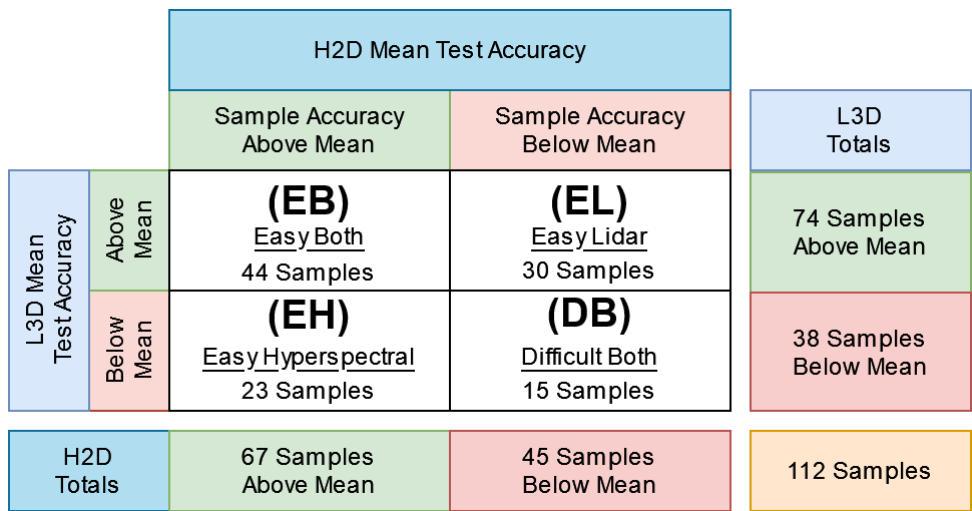
Figure 11. Categorization matrix for test samples. The mean test set accuracy for the H2D and L3D models are calculated. Each test sample is then categorized into one of four types based on the pixel accuracy achieved by both H2D and L3D against the sample. Test sample accuracies above the model mean are categorized as “easy”, whilst accuracies below the model mean are categorized as